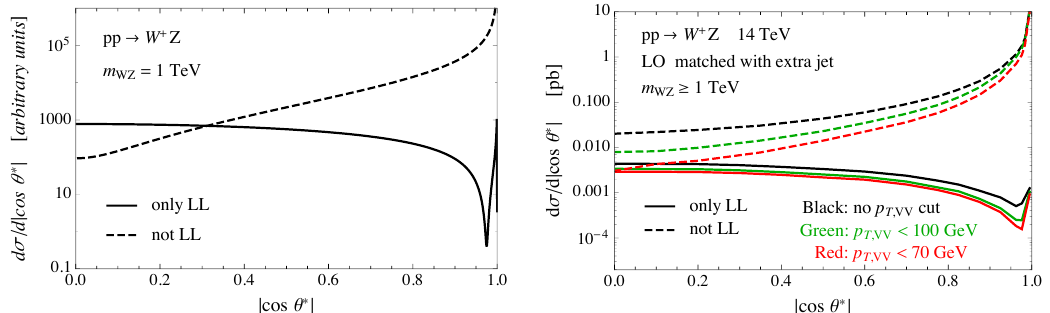
Figure 4 . Di(cid:11)erential cos (cid:18) ! W + Z , where the solid (dashed) lines correspond (cid:3) cross-section for pp to the (cid:12)nal state with two longitudinally polarized gauge bosons (all the other polarizations). Left: LO results at invariant mass m wz = 1 TeV. Right: tree-level results matched with an extra jet with invariant mass m wz (cid:21) 1